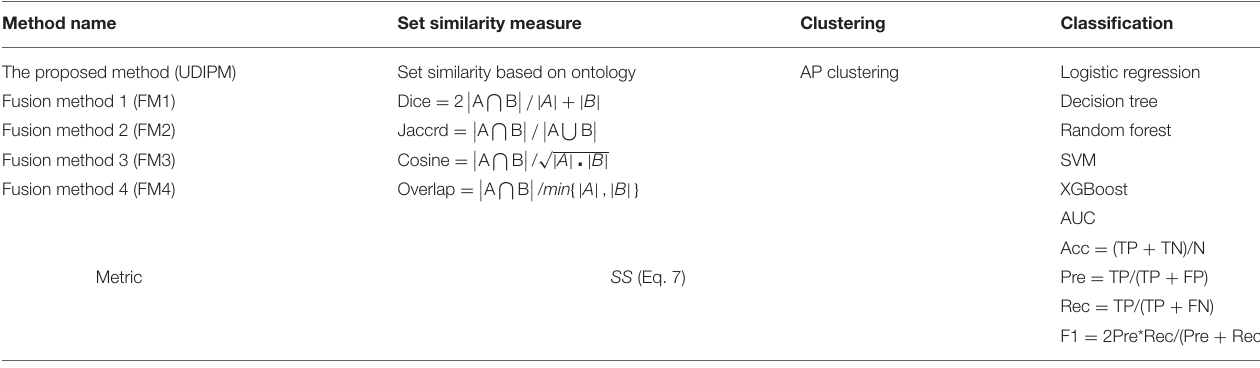
TABLE 4 | Evaluation methods and metrics used in our experiment.